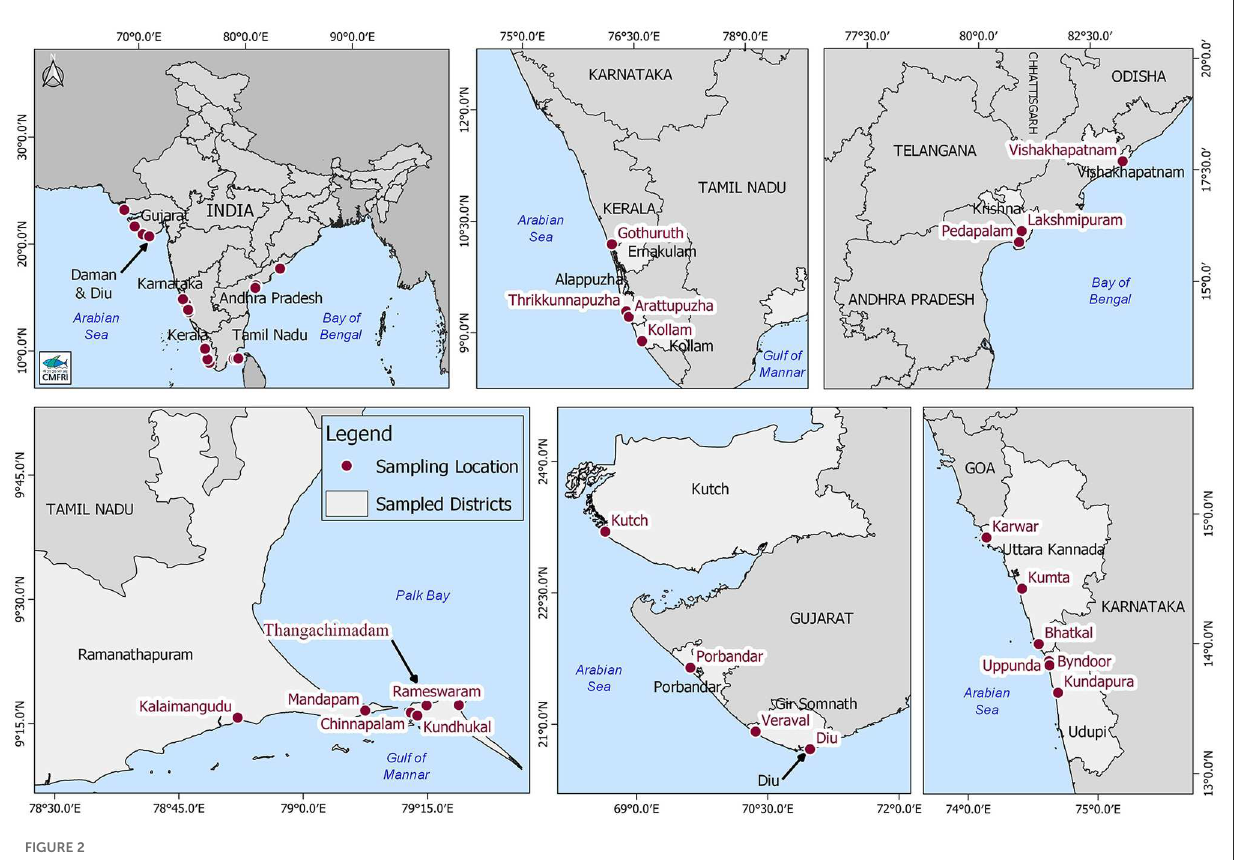
FIGURE2 Map depicting the sampling locations of the